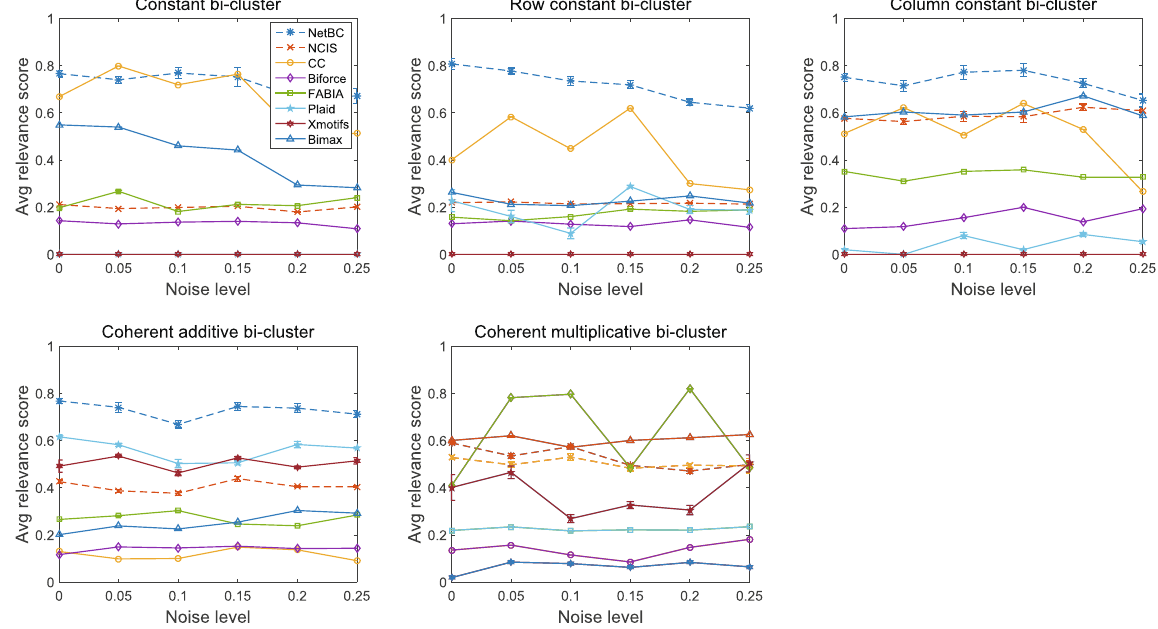
Figure 6. Relevance of bi-clustering methods on five types of bi-clusters.